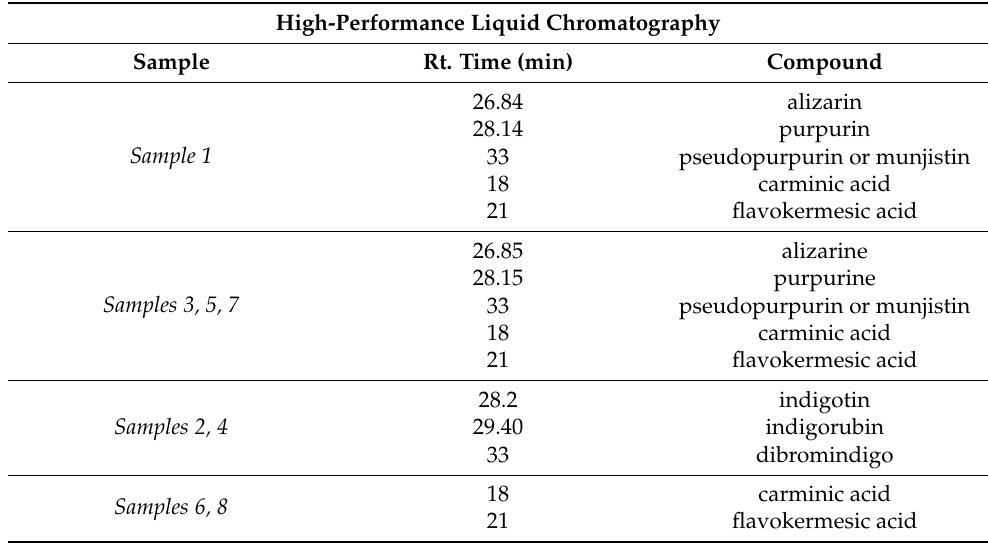
Table 3. Traces of dye components on extracts from textile samples determined by HPLC chroma- tography.